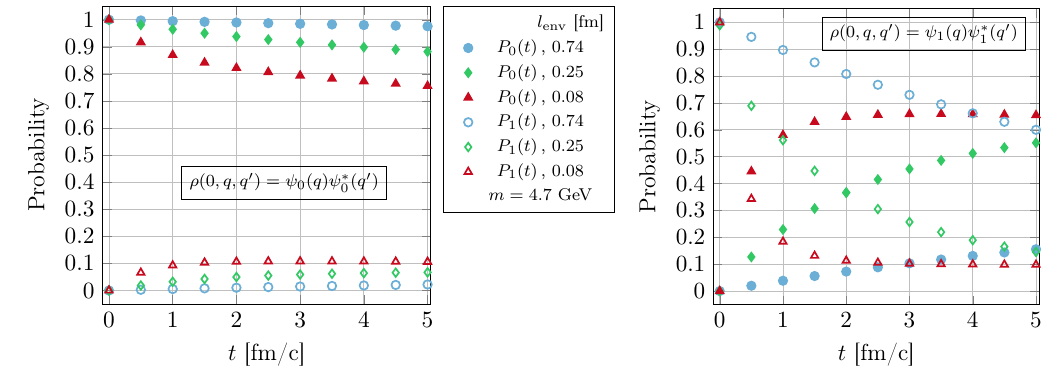
Figure 9 . Probabilities P 0 ( t ) ; P 1 ( t ) of having respectively the ground state 0 and the excited state 1 at time t . Here l